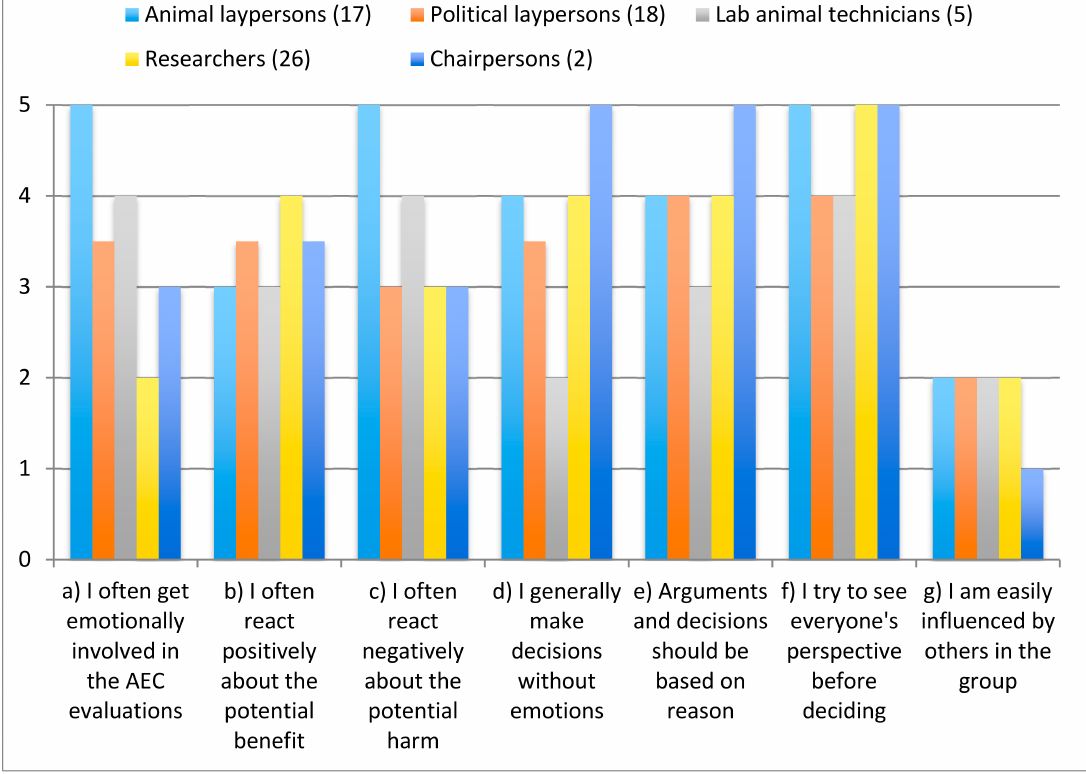
Figure 3. Aspects of emotional involvement in the AEC process. Statements were scored from 1 (completely disagree) to 5 (completely agree). See full statements in Appendix A, question